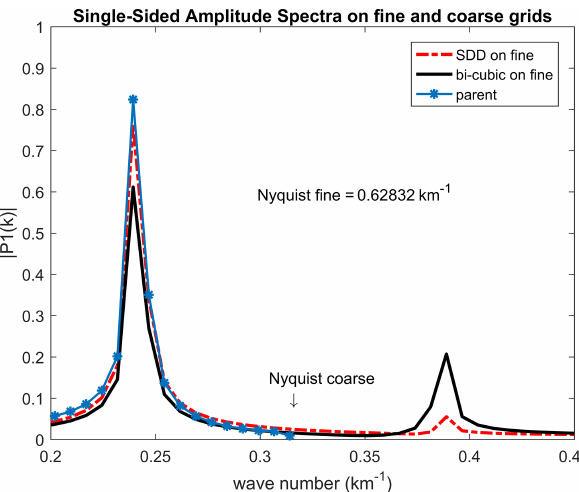
Figure 4. Amplitude spectra of parameter F on a zonal transect at y = 40km (see map in Fig. 1) based on data from the parent model on the coarse grid (blue-star line), SDD method (red) and bi- cubic interpolation (black). For clarity only the central part of the spectrum showing the peaks is